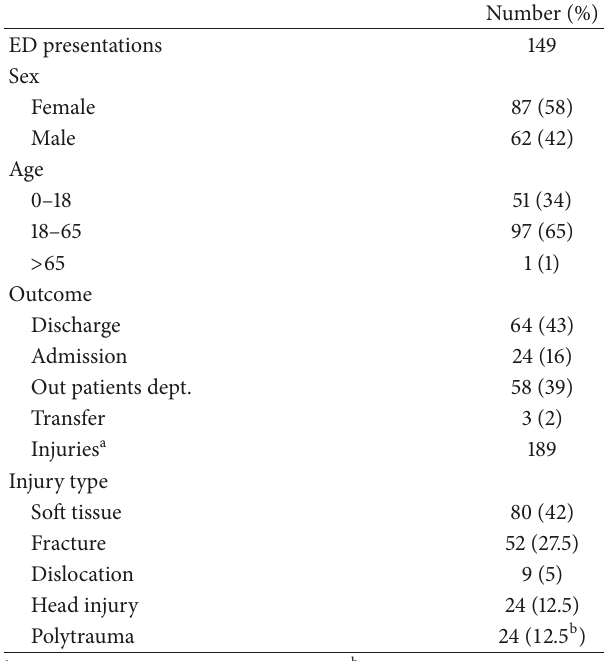
Table 1: Demographics, type of injury, and outcome of equestrian related